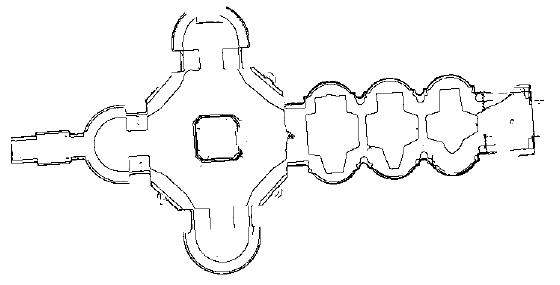
Figure 12. 2D Representation